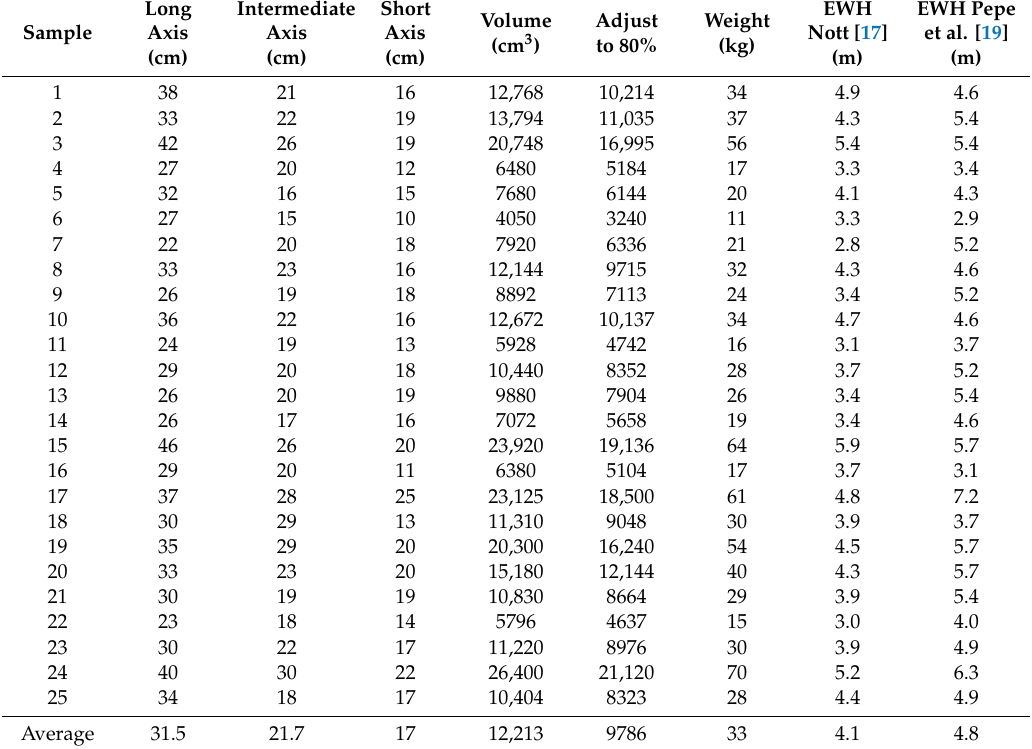
Table A2. Quantification of clast size, volume, and estimated weight from a sample at the top of the pass at Støypet (Locality 2). The density of low-grade chromite at 3.32 g / cm 3 is applied uniformly in order to calculate wave height for each boulder. Abbreviation: EWH = estimated wave height.